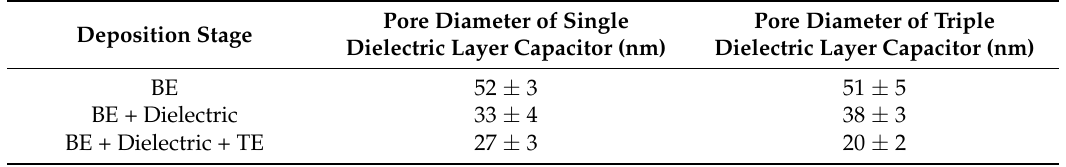
Table 4. Average pore diameters after deposition of the different layers, either BE, dielectric, or TE. Data have been obtained from the analysis of scanning electron microscope (SEM) images with ImageJ